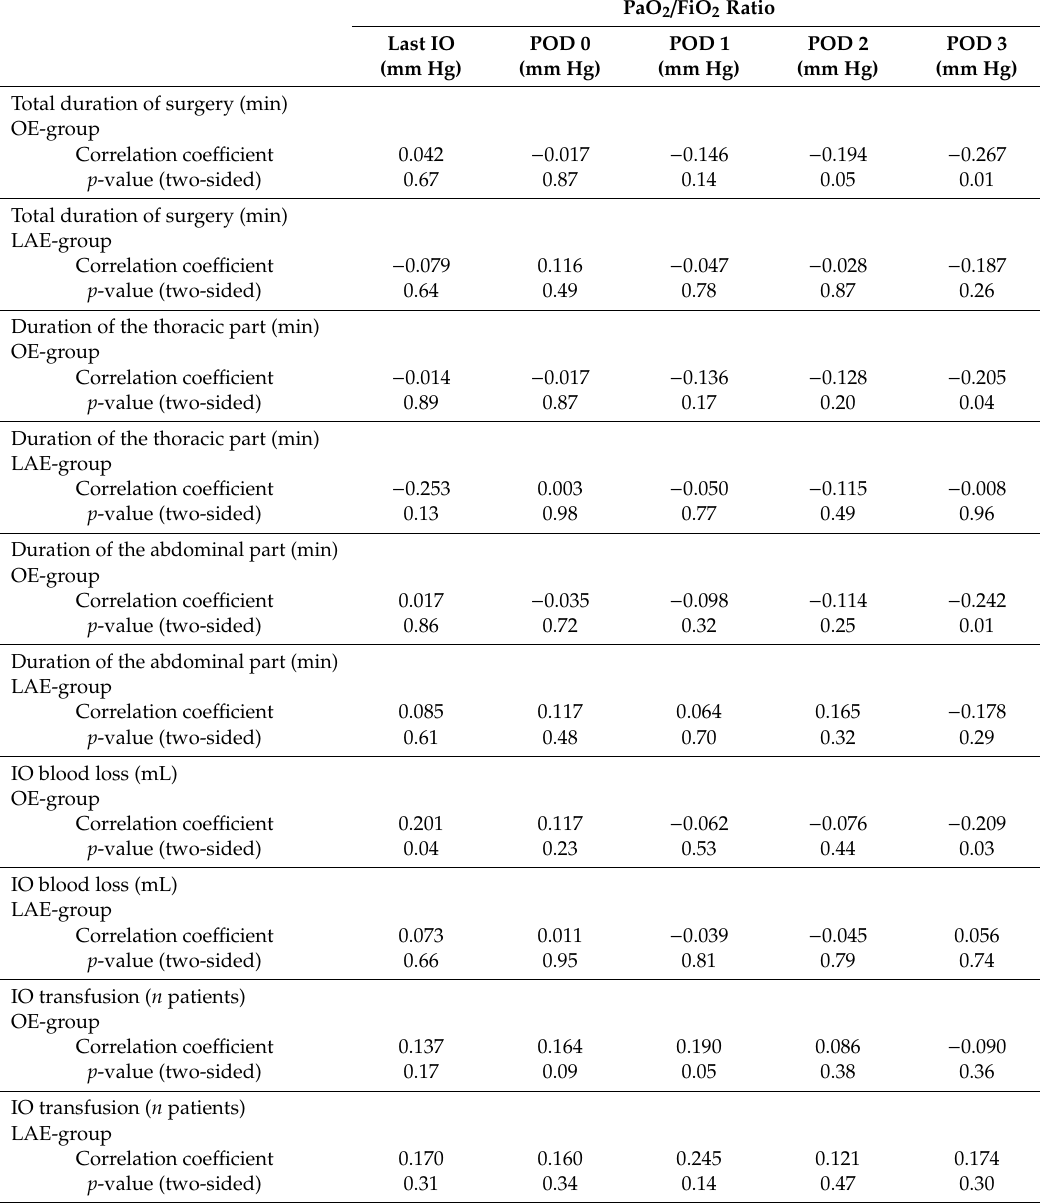
Table 6. Results of Spearman´s Rho rank